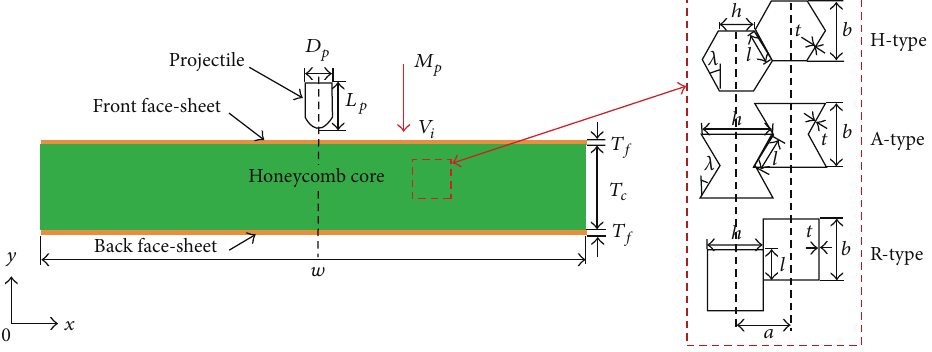
Figure 1: Diagrammatic sketch of the honeycomb sandwich panels (HSPs) under in-plane projectile impact.